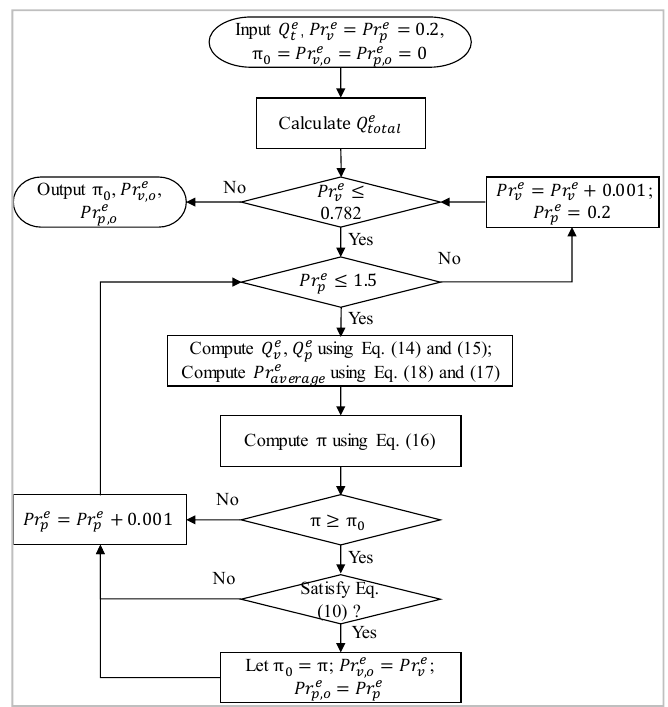
Figure 4. Flow chart of Algorithm (2).